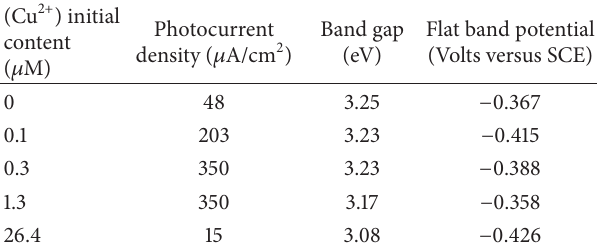
Table 2: Photocurrent density, band gap, and flat band potential of undoped and ZnO